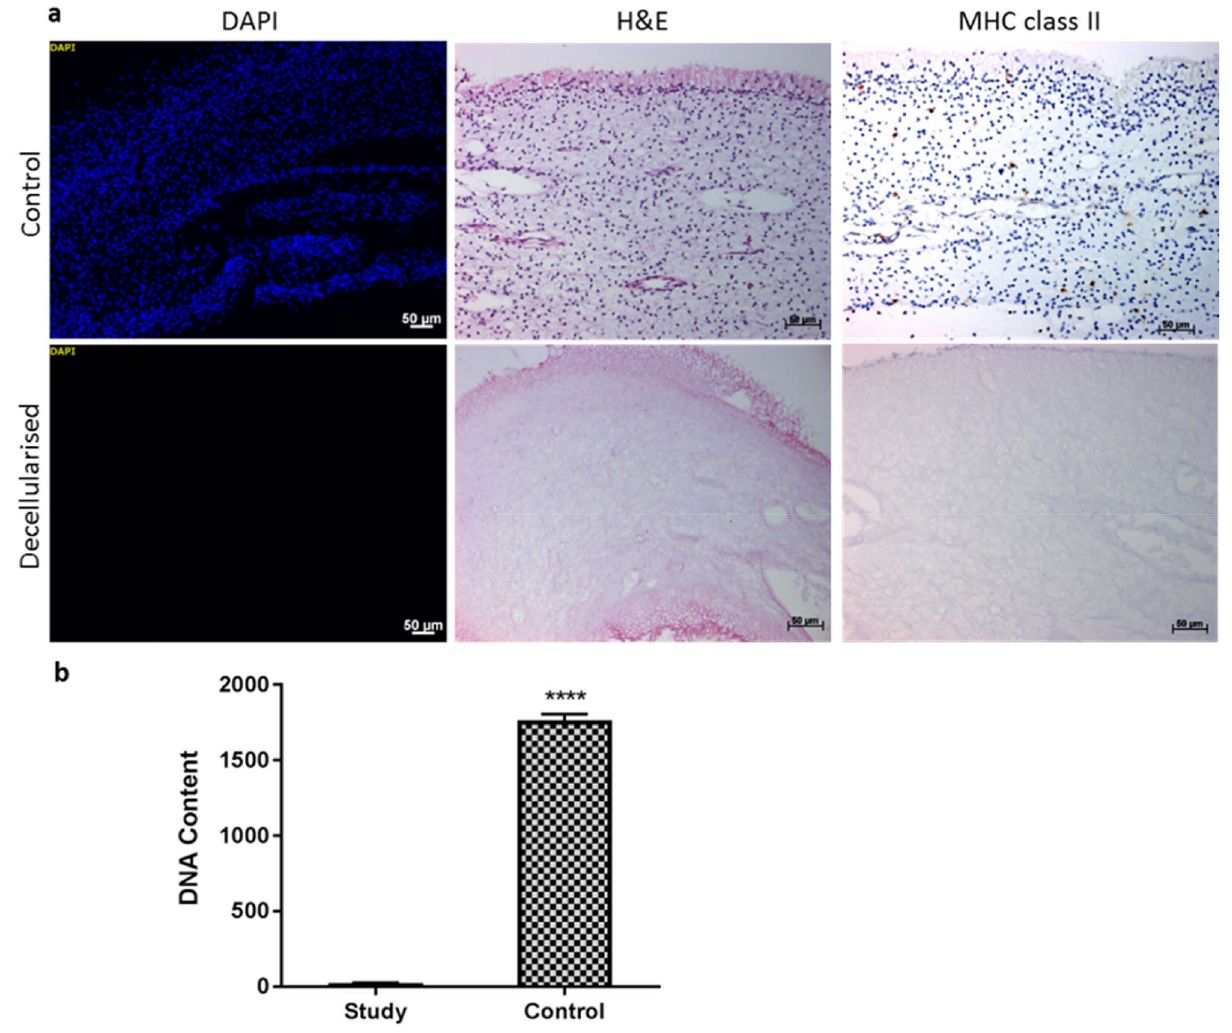
comparison to no nuclear material staining of decellularised tissues. A positive immunoreactivity against major histocompatibility complex class II antigens were seen in control tissues, in contrast a negative immunoreactivity in decellularised tissues. ( b ) Bar graph results of DNA quantification assay determined by Nanodrop spectrometer. Y-axis; DNA content ng per mg of dry tissue. Data represent mean values ( n = 4) ± 95% confidence intervals. The mean DNA measurements in the decellularised tissues contained 23.00 ± 1.43 ng/ mg in comparison to 1756 ± 20.66 ng/mg in the control tissues ( t test, **** p < 0.0001). DAPI 4 ′ ,6-diamidino-2- phenylindole. Scale bars are at 50